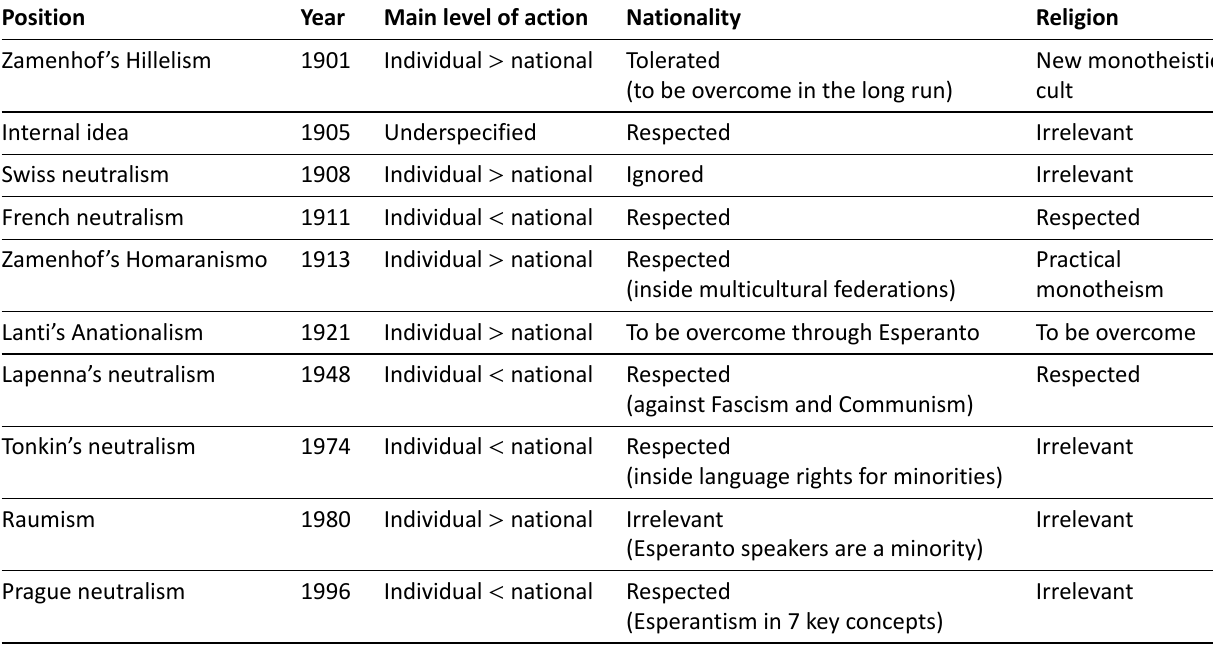
Table 1. The importance of nationality and religion within the mainstream Esperanto Movement across time.